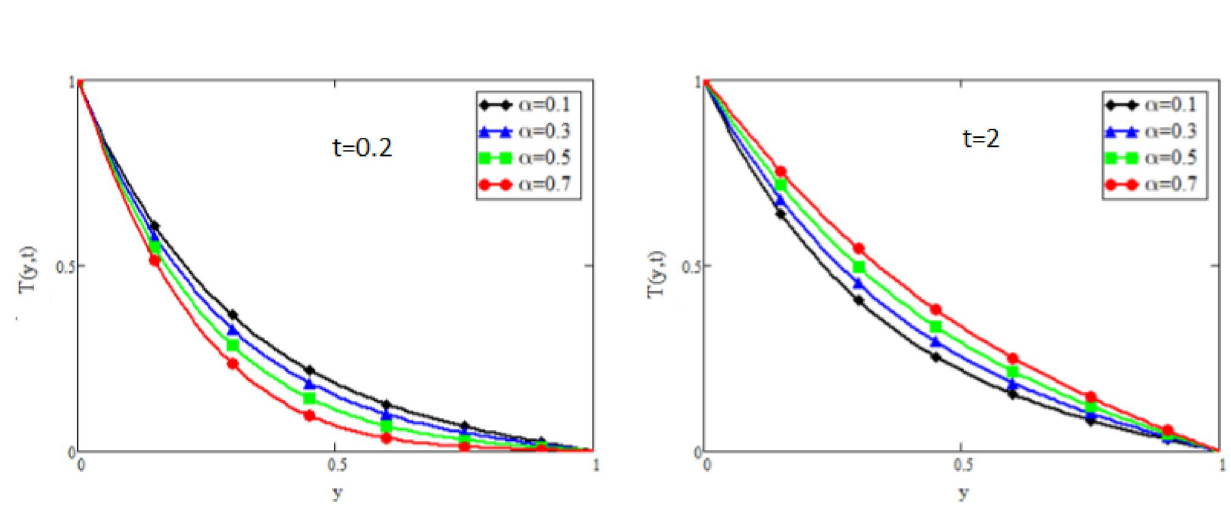
Figure 9. Impact of α on temperature distribution when Pr = 50